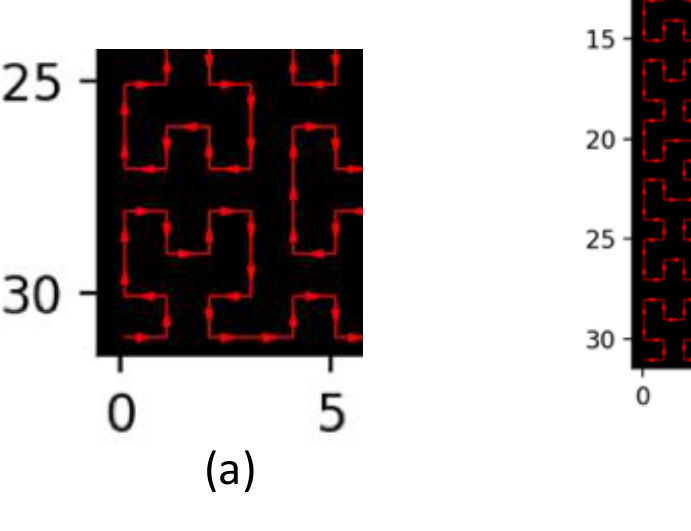
Figure 3. A Hilbert curve was used to encode the image in a linear sequence which attempts, as much as possible, to preserve locality. The red arrows show the scan sequence. ( a ) Shows an expanded view the lower left corner of ( b ) the entire scan sequence.